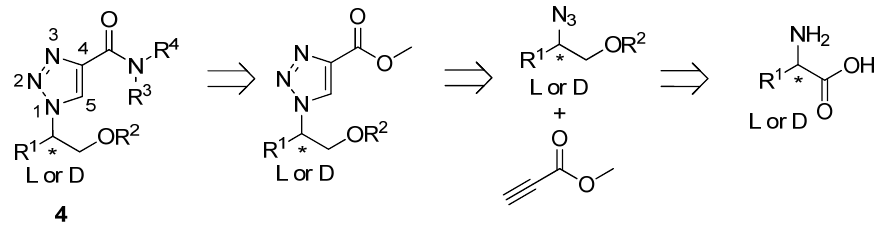
Figure 2. Retrosynthetic strategy for the generation of chiral 1,4-disubstituted-1,2,3- triazole